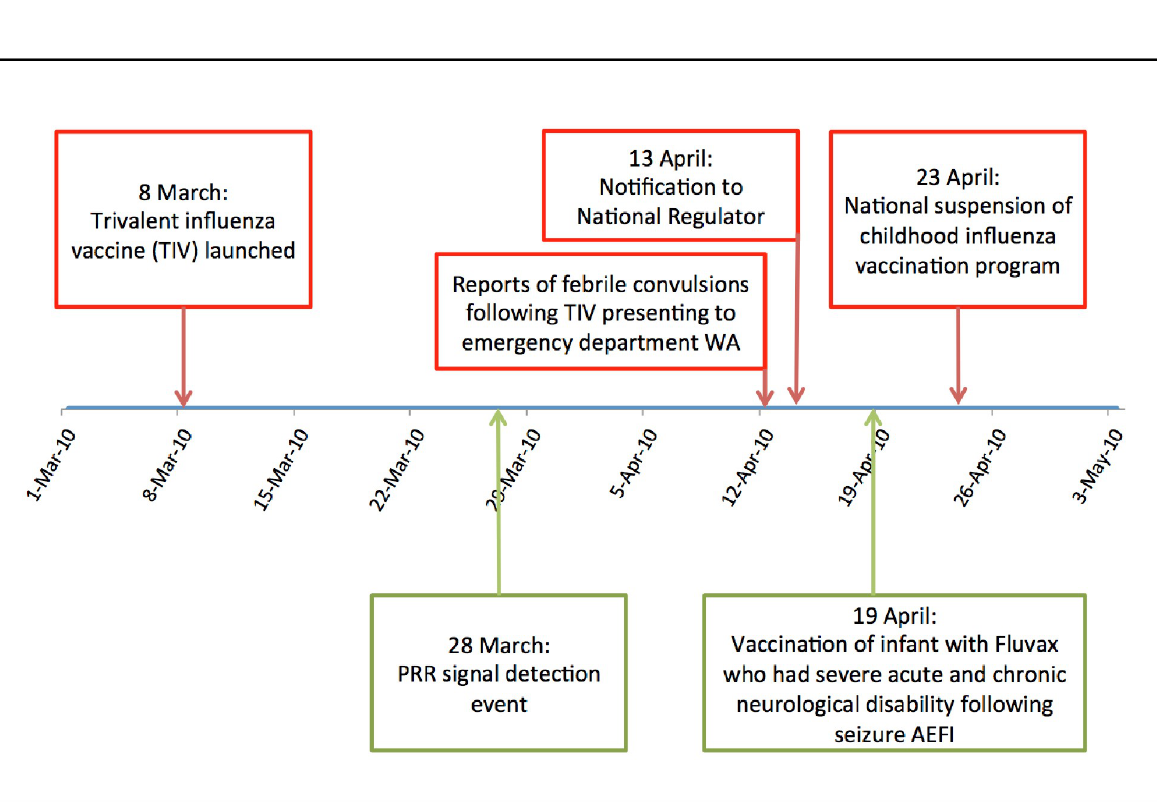
Fig 6. Timeline of 2010 influenza vaccine and fever AEFI signal detection.